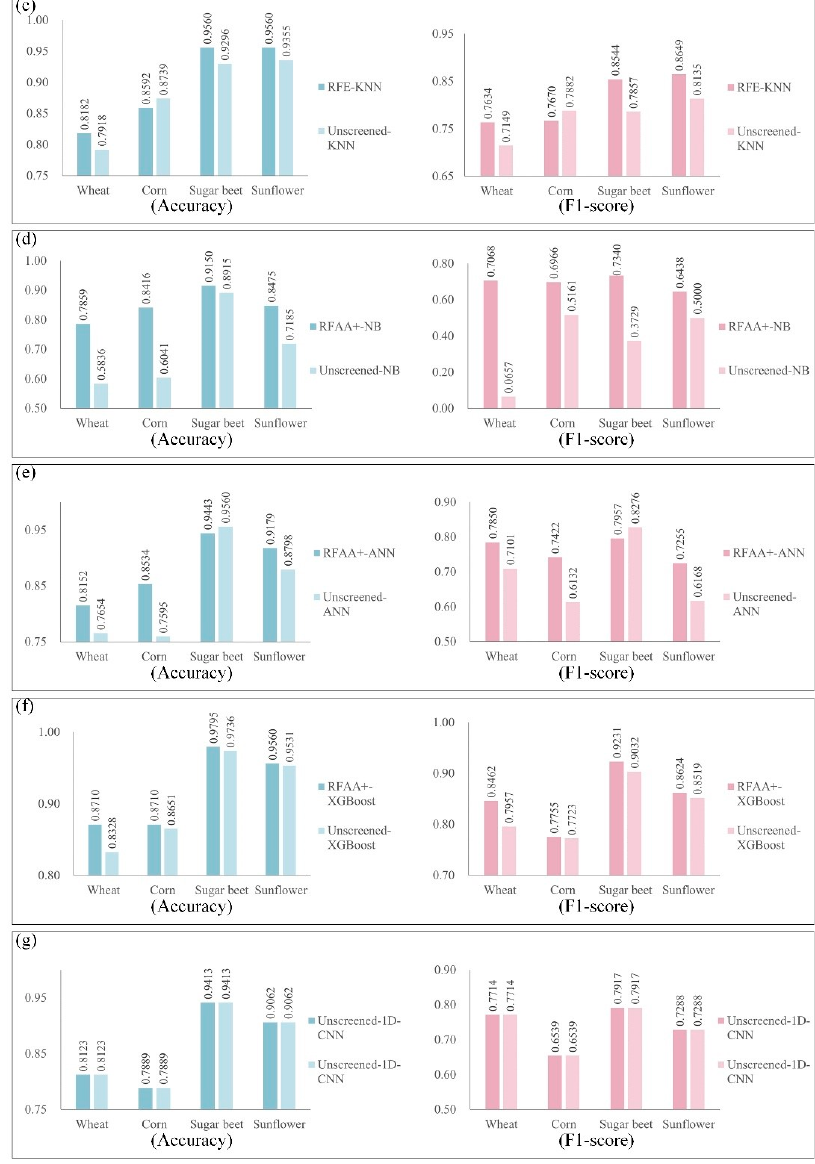
Figure 7. Evaluation indicators of single crop under different FS-ML models: ( a – g ) include the evaluation indicators (e.g., accuracy and F1-score) optimal coupling results of the specific classifier and classifier based on unscreened indexes. ( a ) = classification based on random forest (RF); ( b ) = classification based on support vector machine (SVM); ( c ) = classification based on K-nearest neighbor classification (KNN); ( d ) = classification based on naïve bayes (NB); ( e ) = classification based on artificial neural network (ANN); ( f ) = classification based on Extreme Gradient Boost (XGBoost); ( g ) = classification based on one-dimensional convolutional neural network (1D-CNN). RFAA+ = improved average accuracy reduction; RFAI+ = improved random forest average impurity; RFE = recursive feature